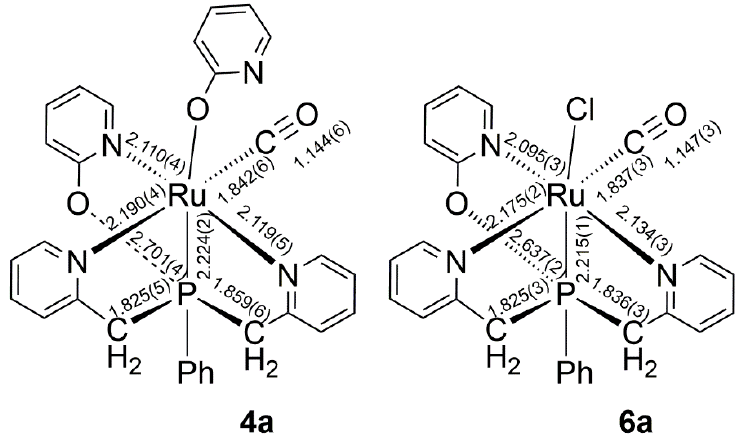
solvent molecules are omitted for clarity), selected interatomic distances (Å) and angles (deg.) of